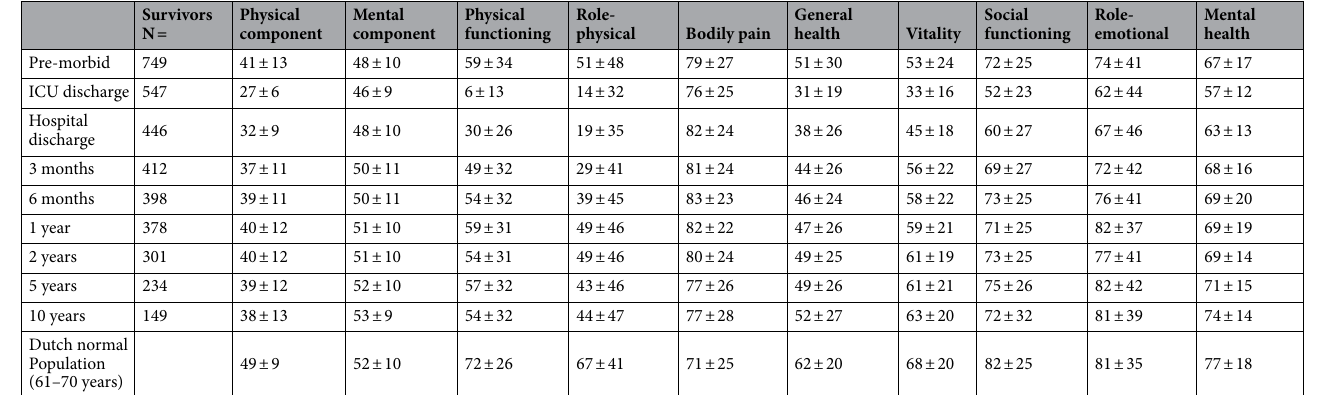
Table 1. Health-related quality of life from ICU admission to 10 years after ICU discharge. Values indicate mean ± SD. SF-36 dimension scores are 0–100 scores. Physical Component Score and Mental component scores are converted to mean 50 (SD